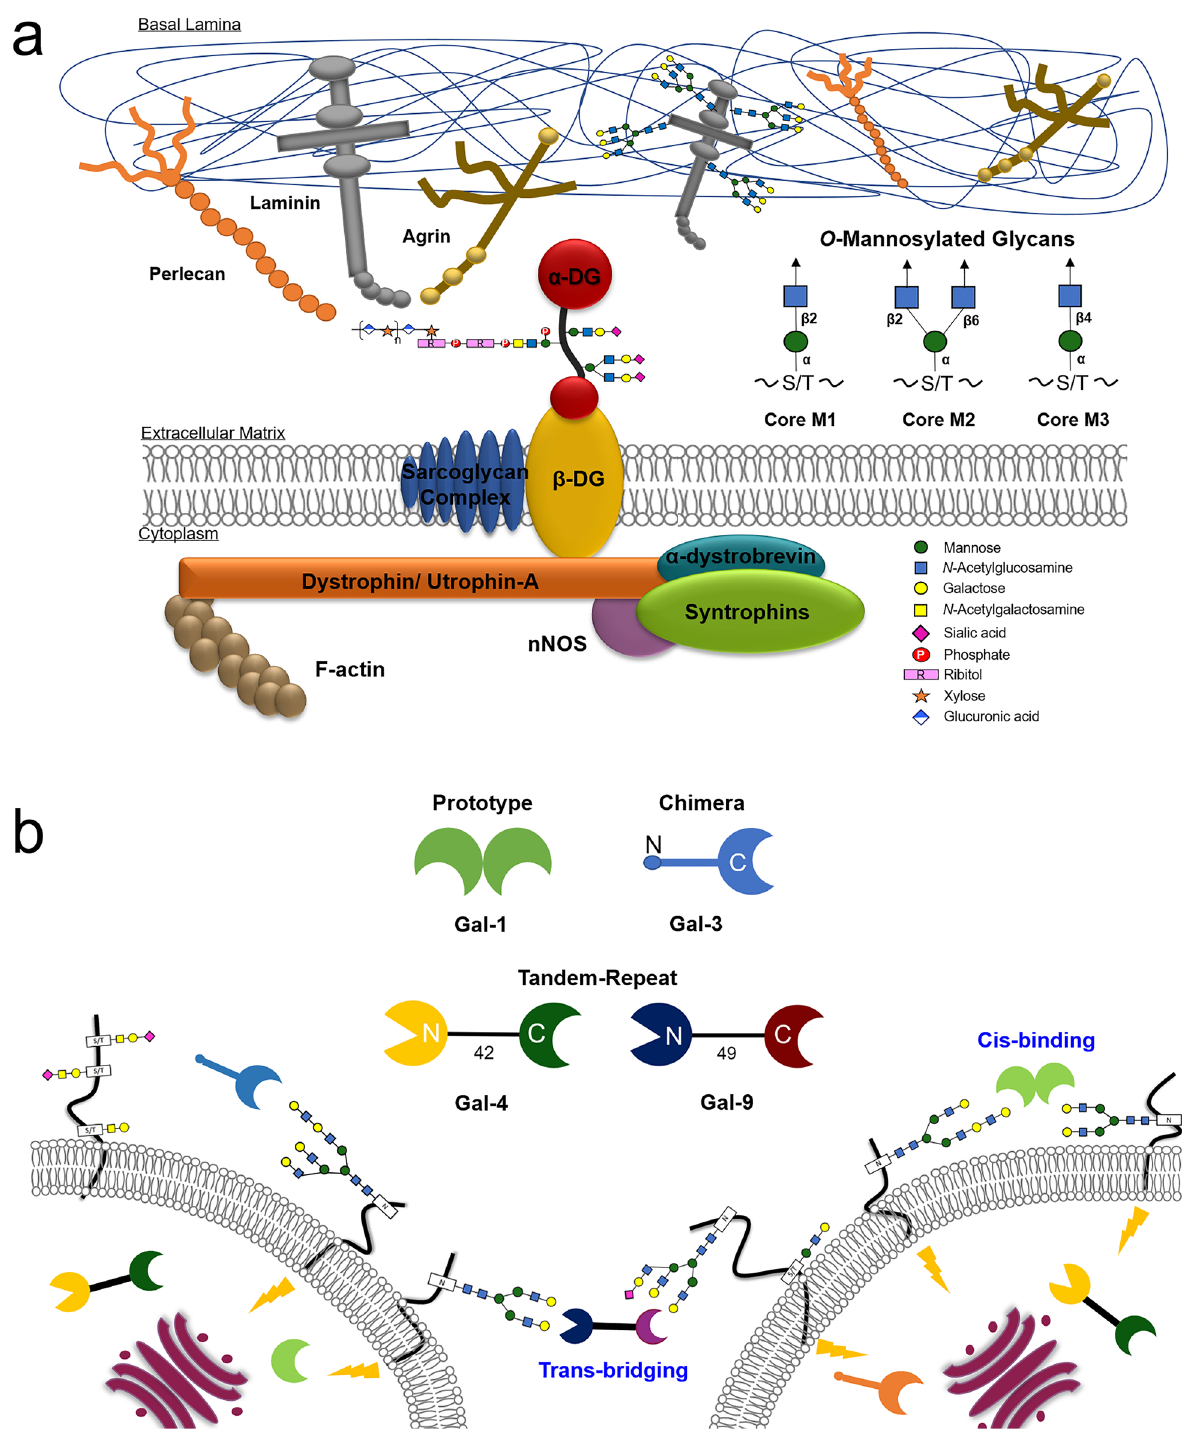
Figure 1. The dystrophin-glycoprotein complex (DGC) and O -mannosylated glycans identified on α-DG ( a ). Galectin test panel covering the three types of vertebrate galectins: prototype (Gal-1), chimera (Gal-3), and tandem-repeat type (Gal-4 and -9) ( b ). CRD positioning relative to the termini is designated by N and C. The cis-binding and trans-bridging activity of galectin is also